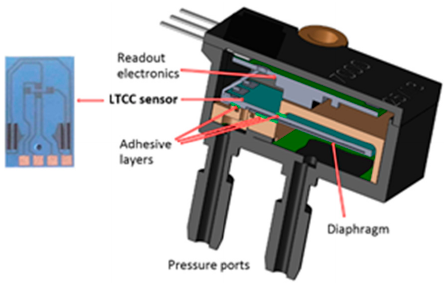
Figure 1. Schematic presentation of the cross section of the LTCC sensor in the housing for differential pressure measurements in a wet-wet application.